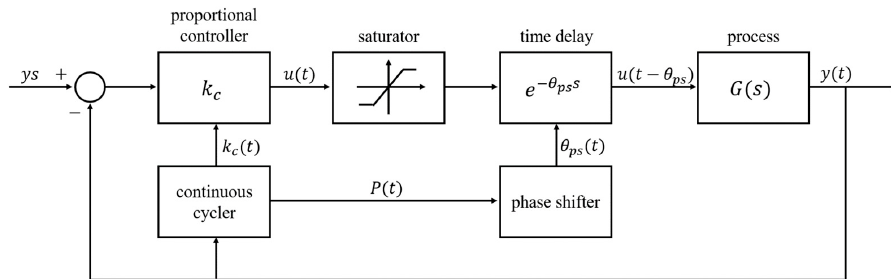
Figure 1. Schematic diagram of the proposed method.